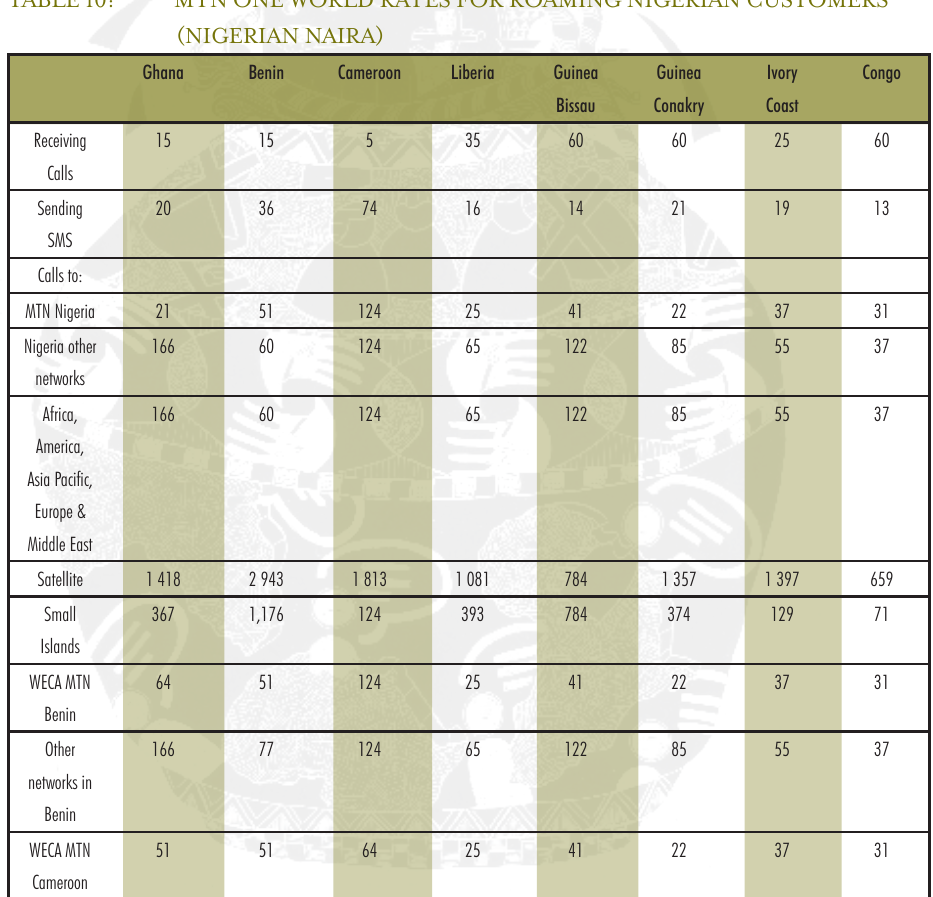
MTN ONE WORLD RATES FOR ROAMING NIGERIAN